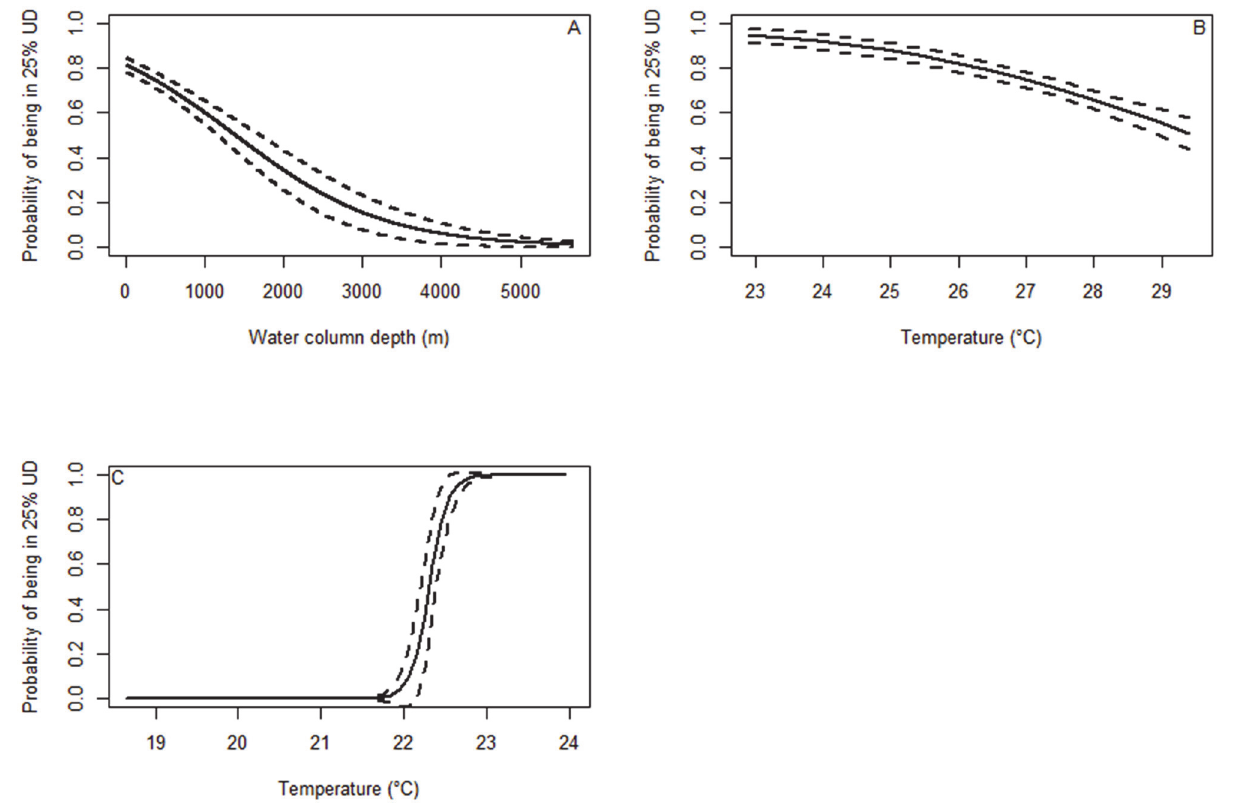
Fig 7. Generalised linear model for Shark 5. Generalised linear model (GLM) predicted probabilities (solid line) of a shark being in a 25% utilisation distribution in relation to (a) water depth, (b) water temperature in the north and (c) in the south. Dotted lines show the standard error.